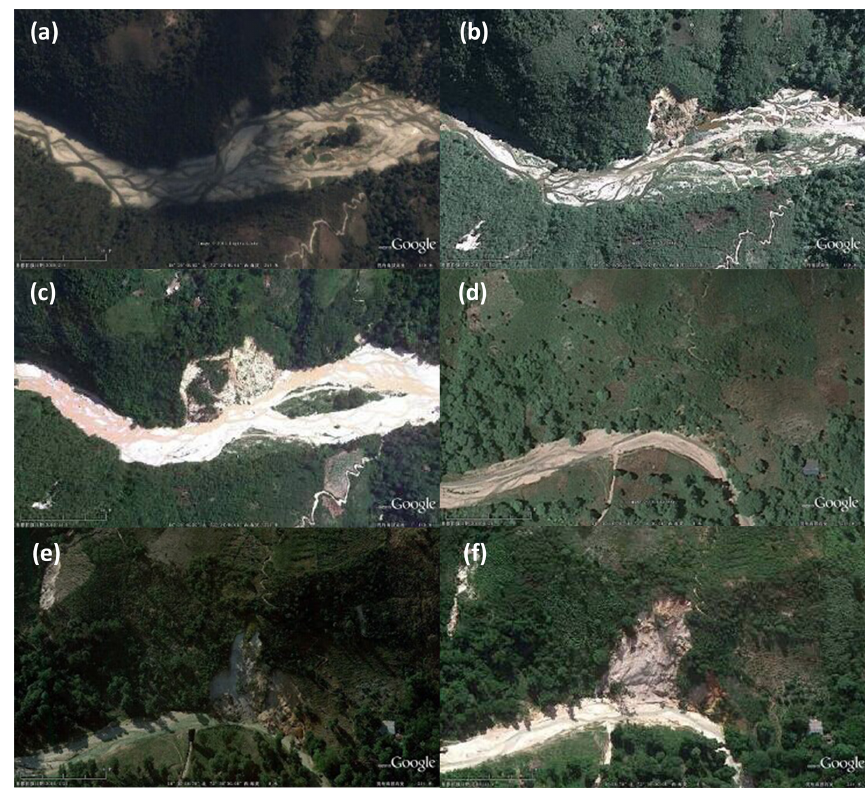
Figure 5. Two places of co-seismic landslides probably enlarged by rainfall. (a) , (b) , and (c) are images showing a landslide located at 18 ◦ 29 0 40.75 00 N, 72 ◦ 24 0 48.69 00 W; the images were taken on 4 February 2009, 13 January 2010, and 9 November 2010, respectively. (d) , (e) , and (f) are images of a landslide located at 18 ◦ 30 0 58.78 00 N, 72 ◦ 30 0 30.08 00 W; the images were taken on 26 August 2009, 25 January 2010, and 9 November 2010,